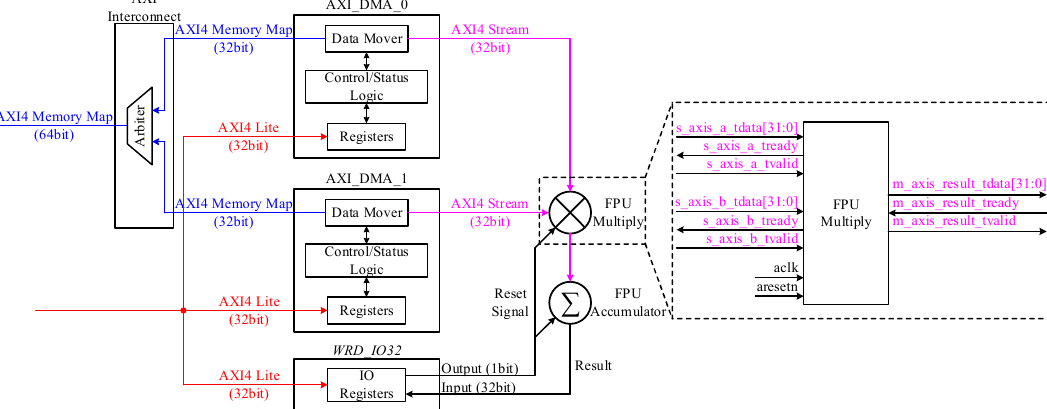
Figure 5. Processing element (PE) architecture without optimization.